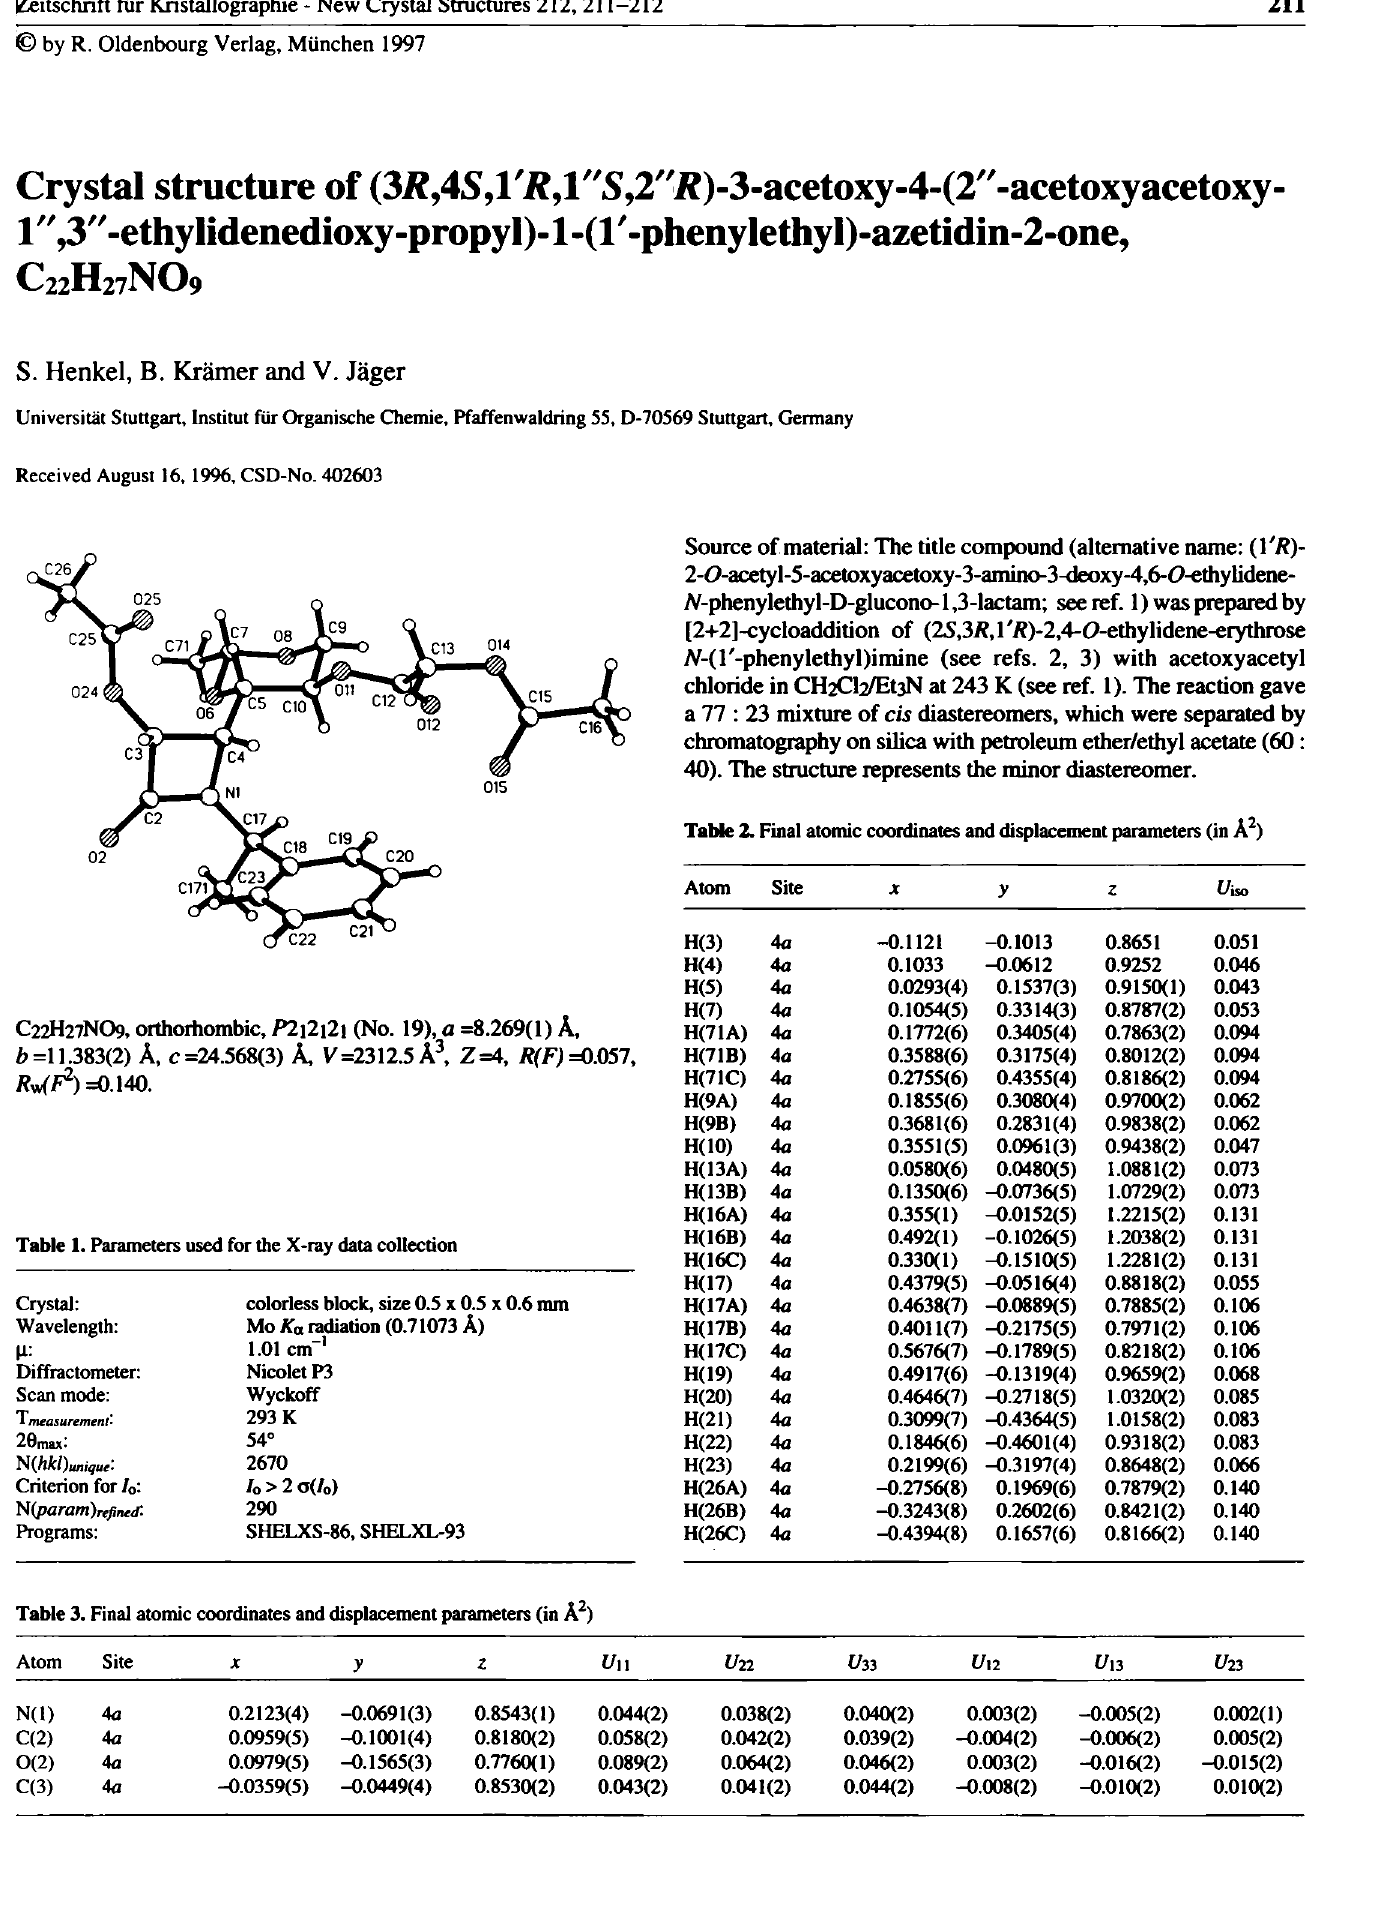
Table 3. Final atomic coordinates and displacement parameters (in Â 2 )